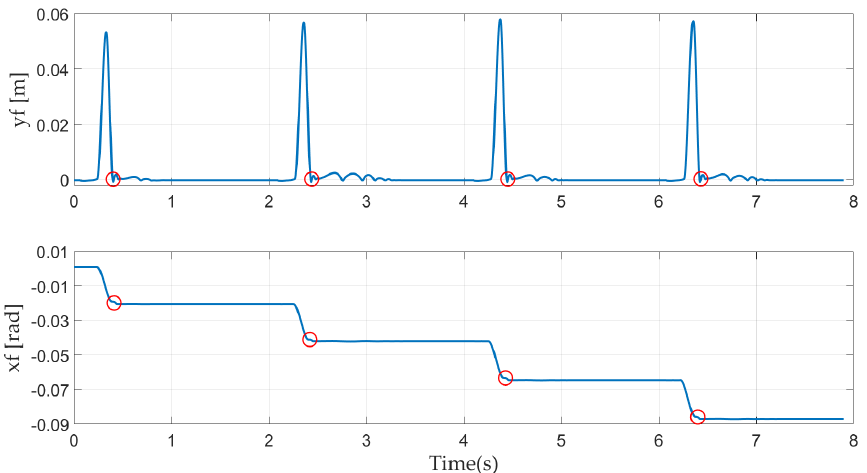
Figure 8. Foot trajectories in the x and y directions.